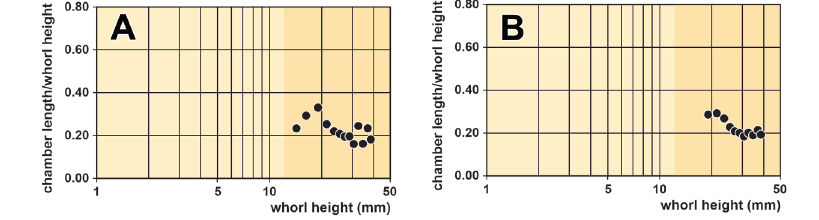
Fig. 22. Ancistroceras barrandei Dewitz, 1880, chamber length/whorl height of specimen MB.C.30516 (Neben & Krueger Coll.) from Rerik (Ostsee). Left = empirical data, right = three data point